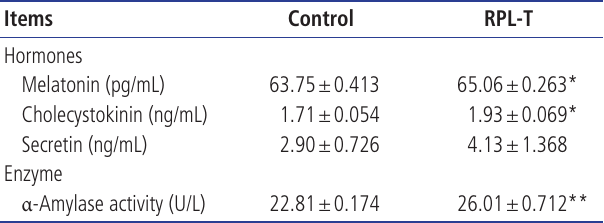
Table 4. Effect of oral administration of rumen-protected L-tryptophan for 5 days on levels of serum MEL, GIH, and duodenum α -amylase in Korean native